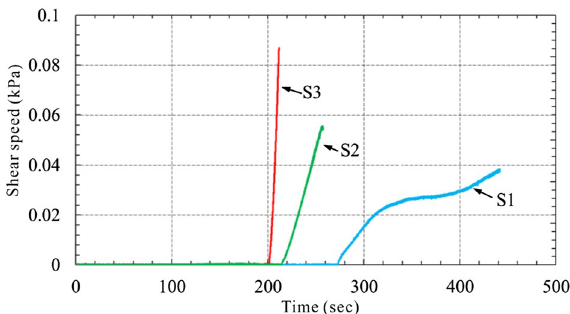
Figure 15. Shear velocity–time